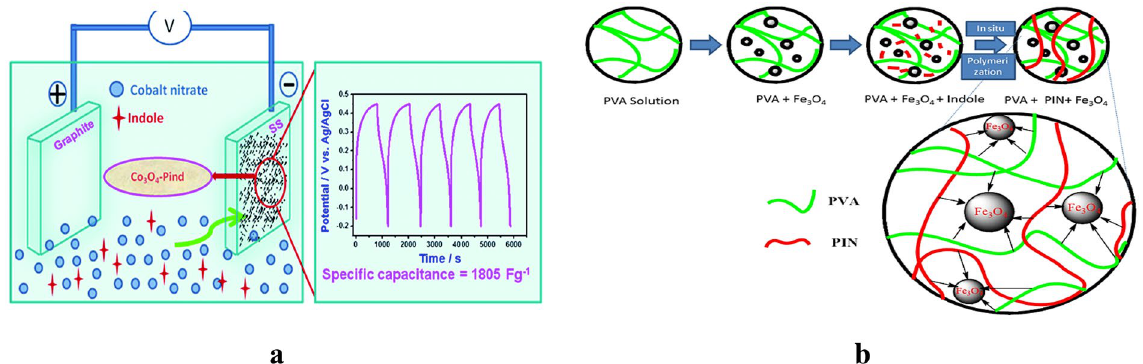
Fig. 3 Graphical representation of PIN composite and its charge–discharge curve ( a ) [34]; graphical representation of in situ fabrication of PIN composite ( b ) [13] Fig. 4 Interaction mechanism between PIN/Fe and porphyrin